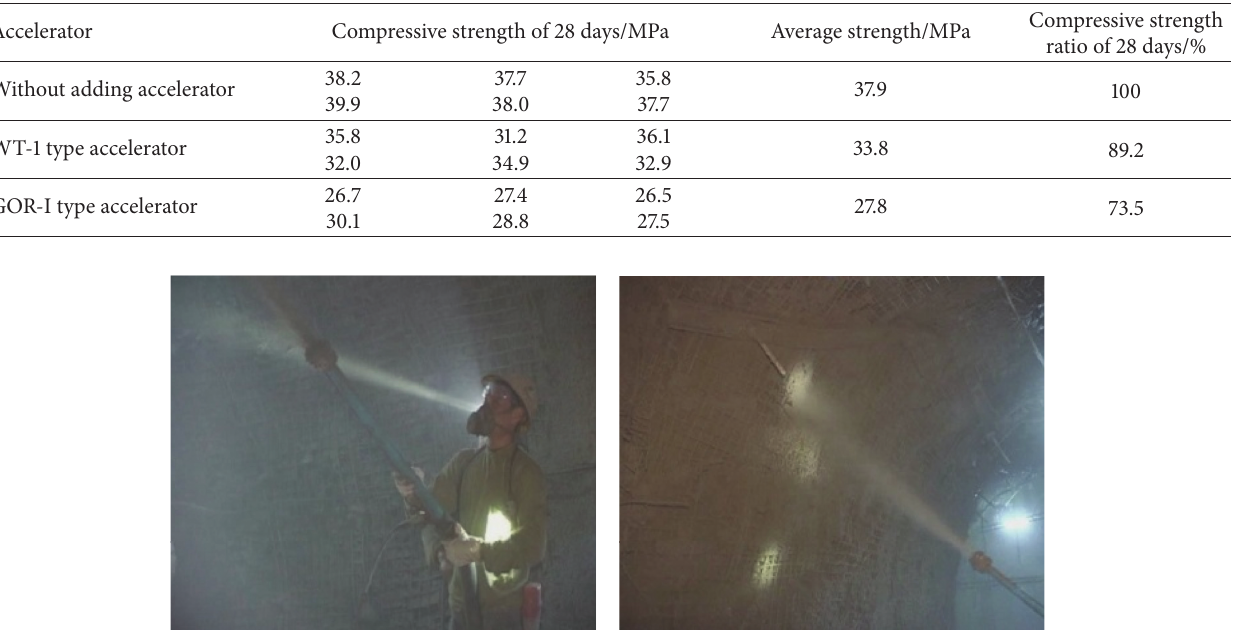
Table 16: Testing results of compressive strength about sprayed concrete.